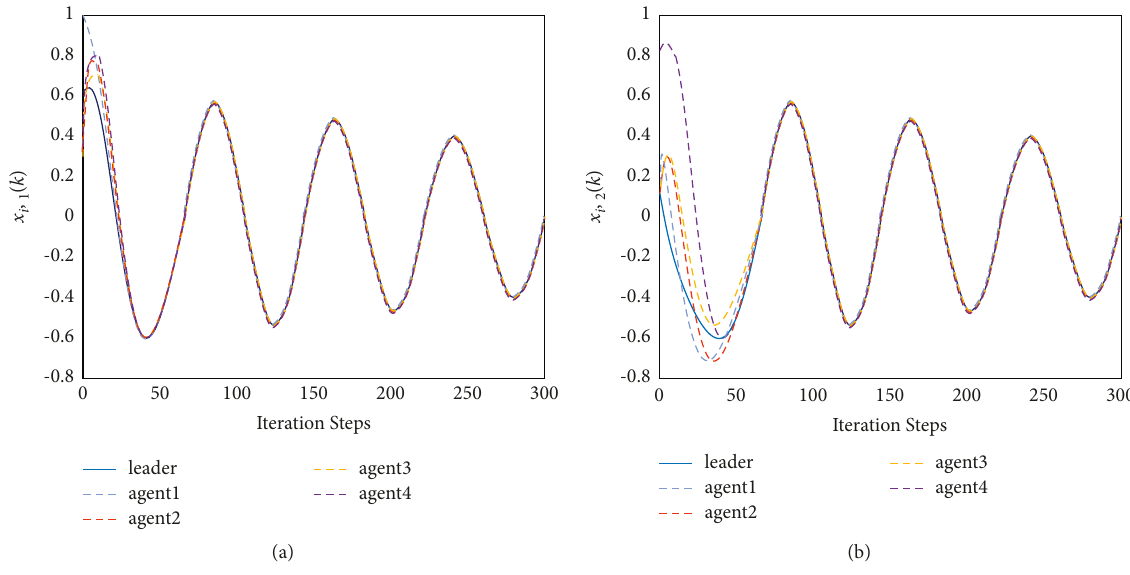
Figure 5: Evolution process of all agent states x